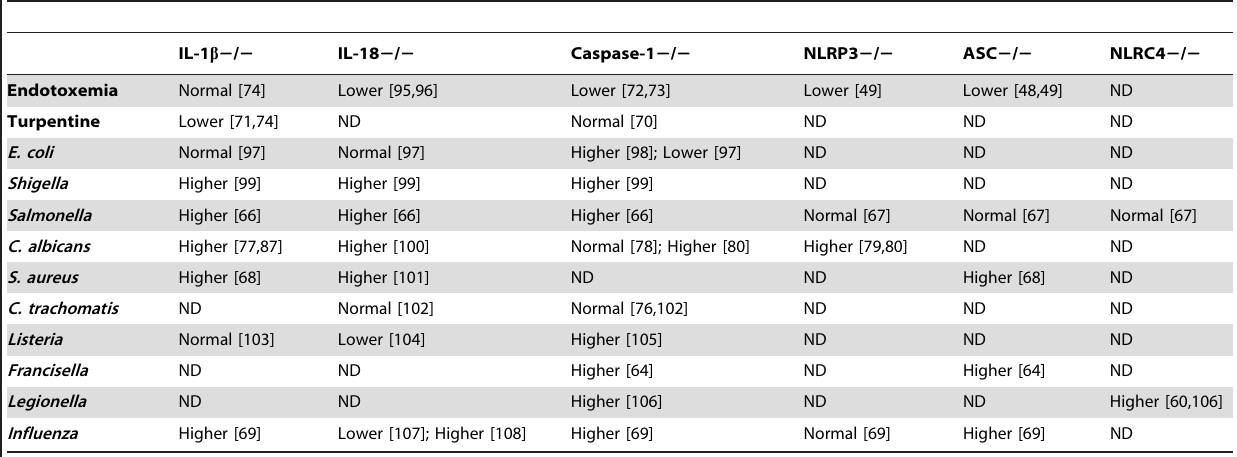
Table 1. Susceptibility to In Vivo Experimental Models of Infection in Mice Deficient in IL-1 b , IL-18, or Inflammasome